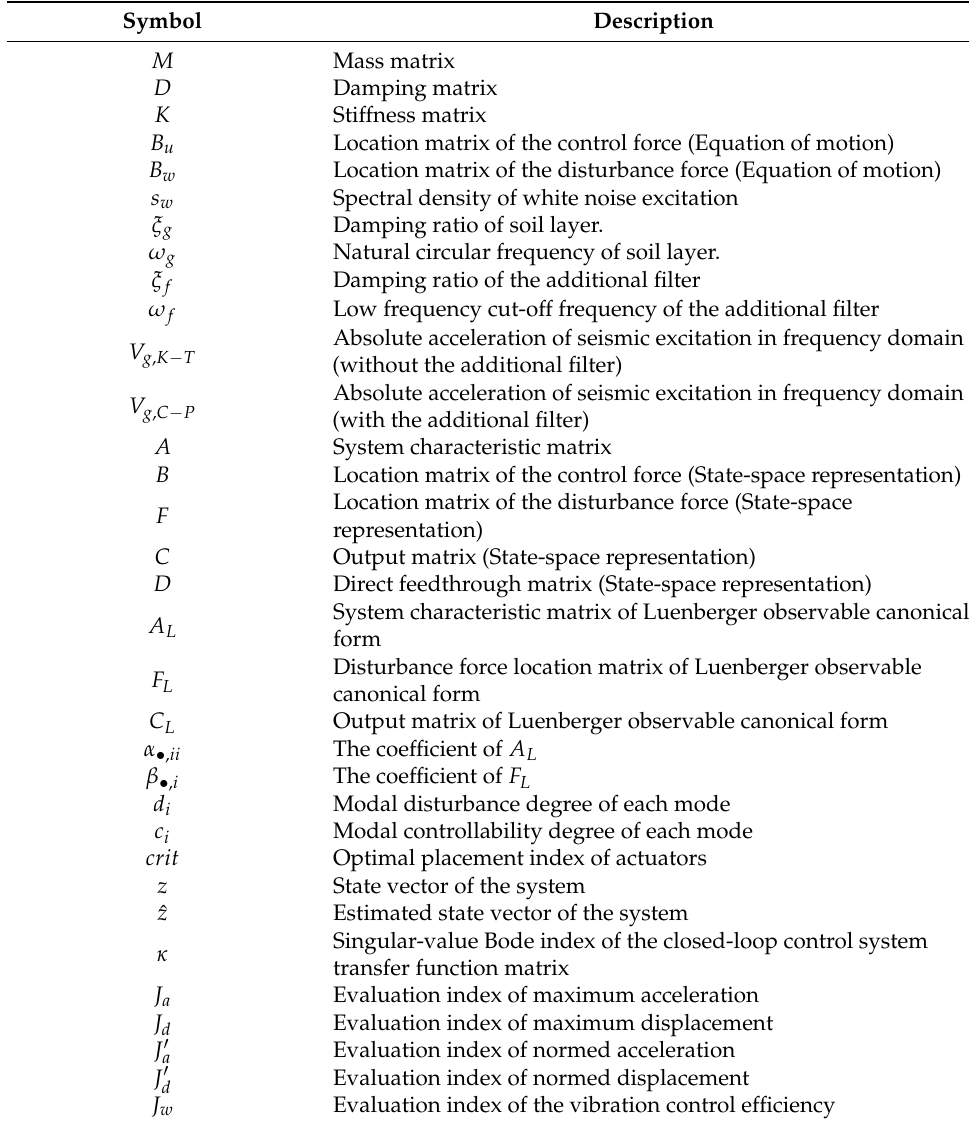
Table A2. List of important symbols used in the